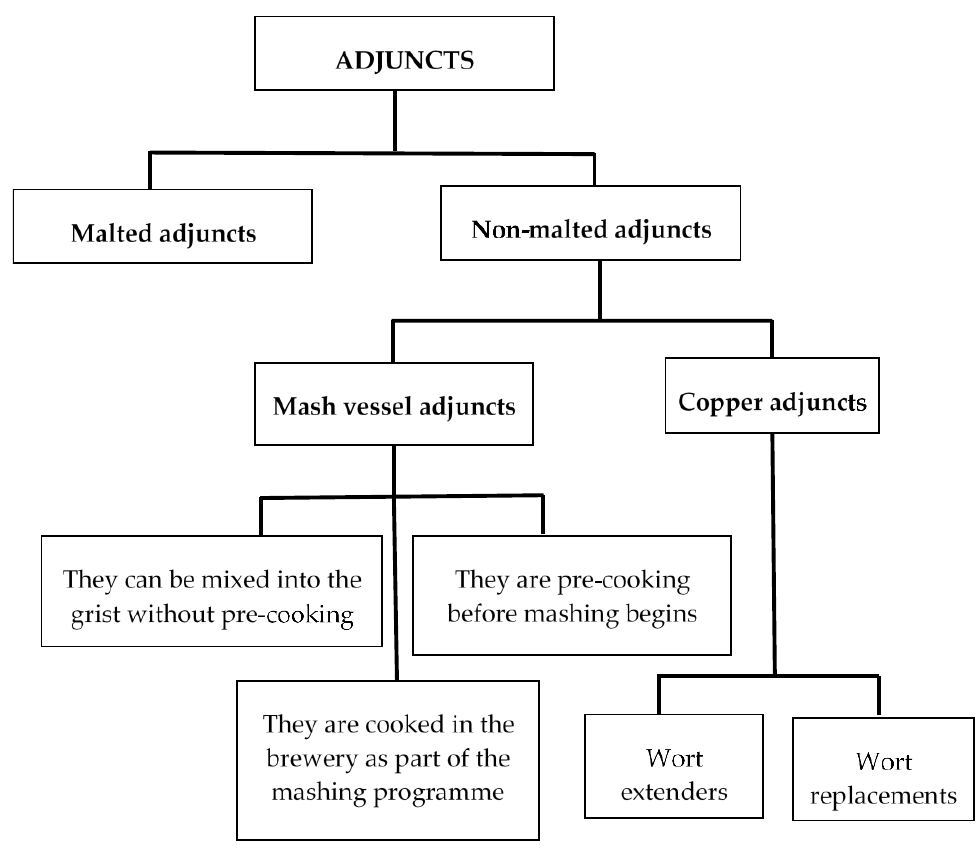
Figure 1. Classification of adjuncts used in